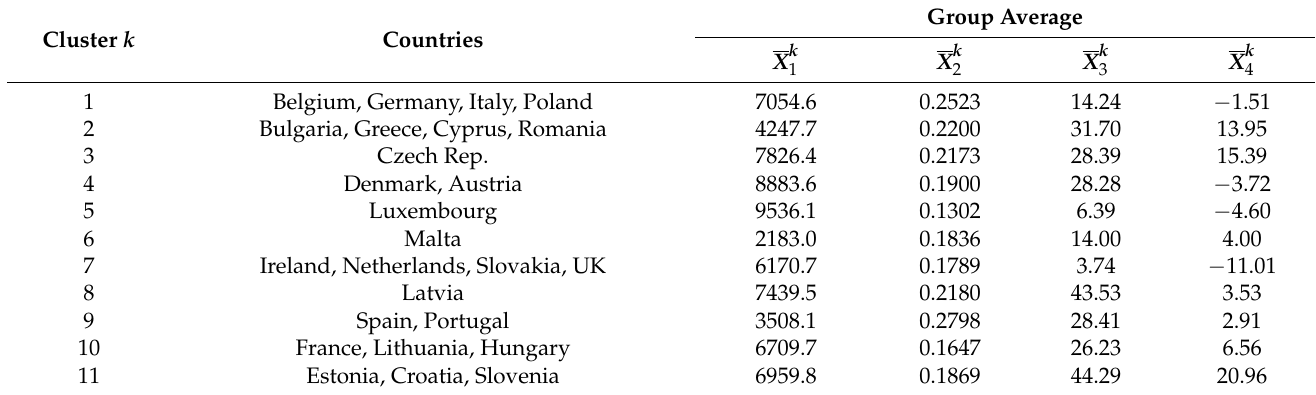
Table 5. Results of the EU countries clustering—the average values of the variables in the clusters (without Finland and Sweden). Cluster